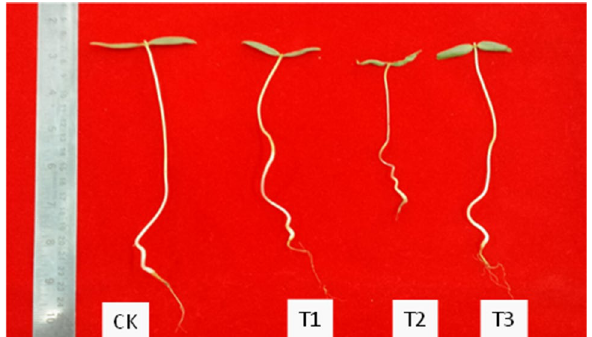
Figure 1. Effect of hemin (0.5 mM) on morphology of Vigna radiata seedlings treated with CdCl 2 (50 μM) for a period of 96 h.